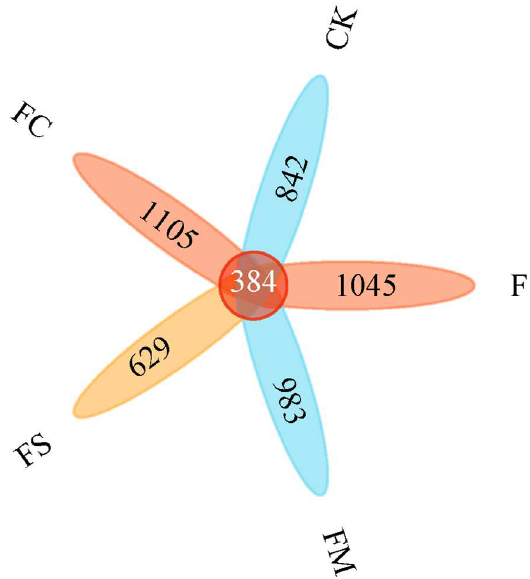
Figure 1. Venn digram of eukaryotic microorganisms OTU under different treatments. Note: F: